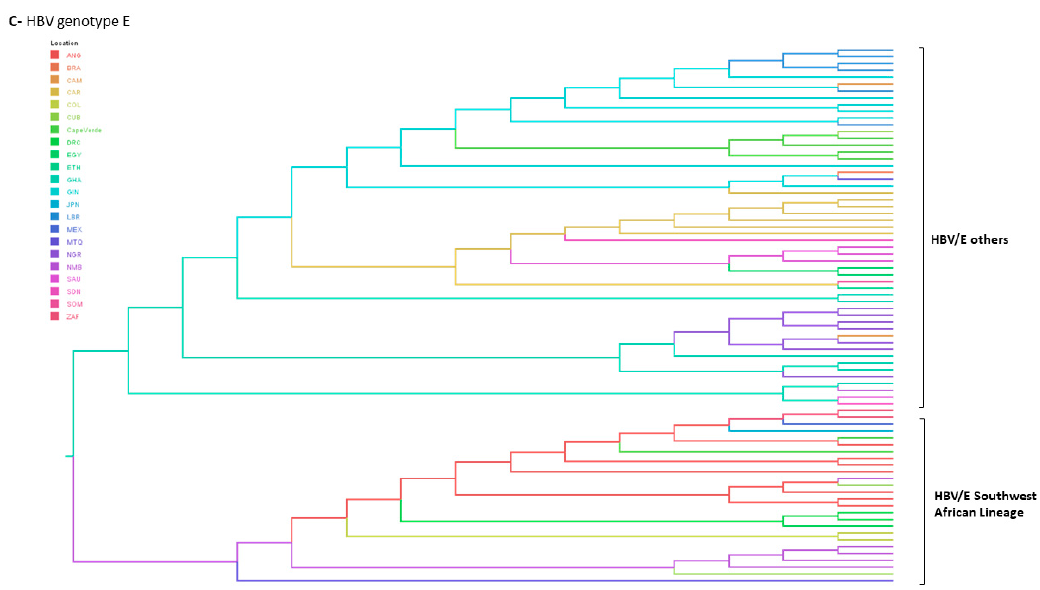
Figure 5. Bayesian maximum clade credibility tree of ( A ) HBV / B, ( B ) HBV / C and ( C ) HBV / E full length genome sequences. B1–B9 and C2–C6 represent HBV subgenotypes within genotypes B and C respectively. HBV / E tree is composed by two branches corresponding to the Southweast African lineage countries (Angola, Namibia and Democratic Republic of the Congo) and the other HBV / E sequences found in other African countries. Branches are coloured according to probable country of origin represented by the following abbreviations: ANG: Angola; ARG: Argentina; BRA: Brazil; CAM: